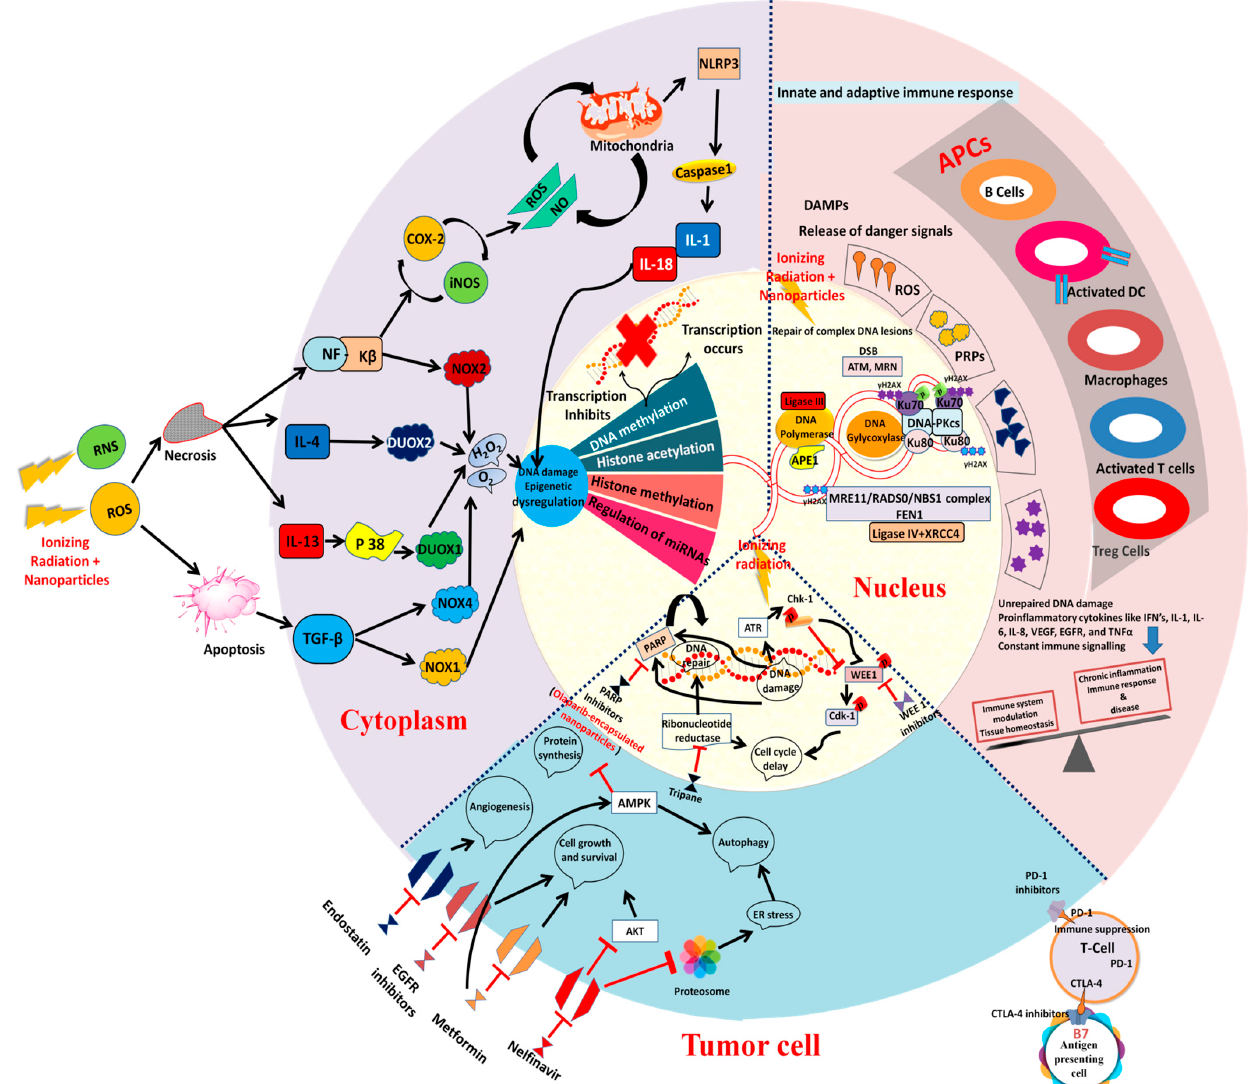
Figure 3. Schematic depiction of the efficacy of nanoparticle formulation in combination with ionizing radiation for inducing (1) necrosis and apoptotic mode of tumor cell death by